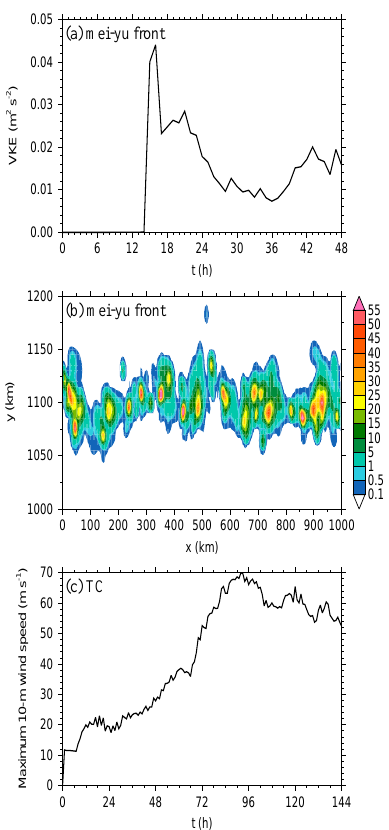
Figure 1. Simulated ( a ) times series of mass-weighted average vertical kinetic energy and ( b ) 1-h accumulated precipitation at t = 26 h (shaded; mm) for the mei-yu front. ( c ) Simulated time series of maximum 10-m wind speed for the tropical cyclone (TC).